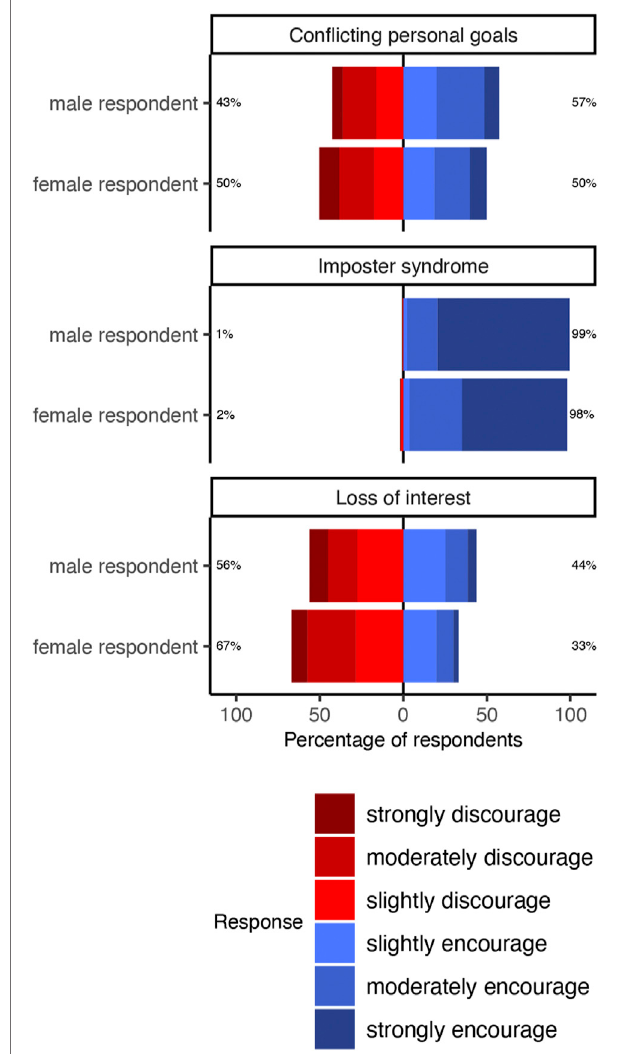
FIGURE 3 | Effect of professor gender and vignette on professors ’ ratings of the extent to which they would encourage or discourage each undergraduate to follow through with plans to go to physics graduate school. Vignettes are titled as the reason each undergraduate presented for reconsidering physics graduate school. Percentages indicate the proportion ofprofessorswhoencouraged (blue)ordiscouraged (red)inresponsetoeach possible pairing of respondent gender and vignette. Across all vignettes, a substantially greater proportion of female professors chose to encourage relative to male